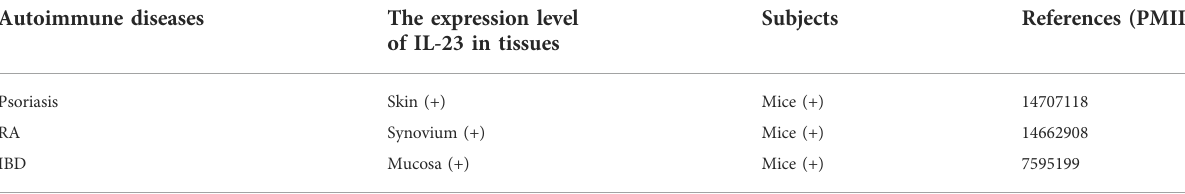
TABLE 3 The expression level of IL-23 in autoimmune disease tissues (pre-clinical research). Autoimmune